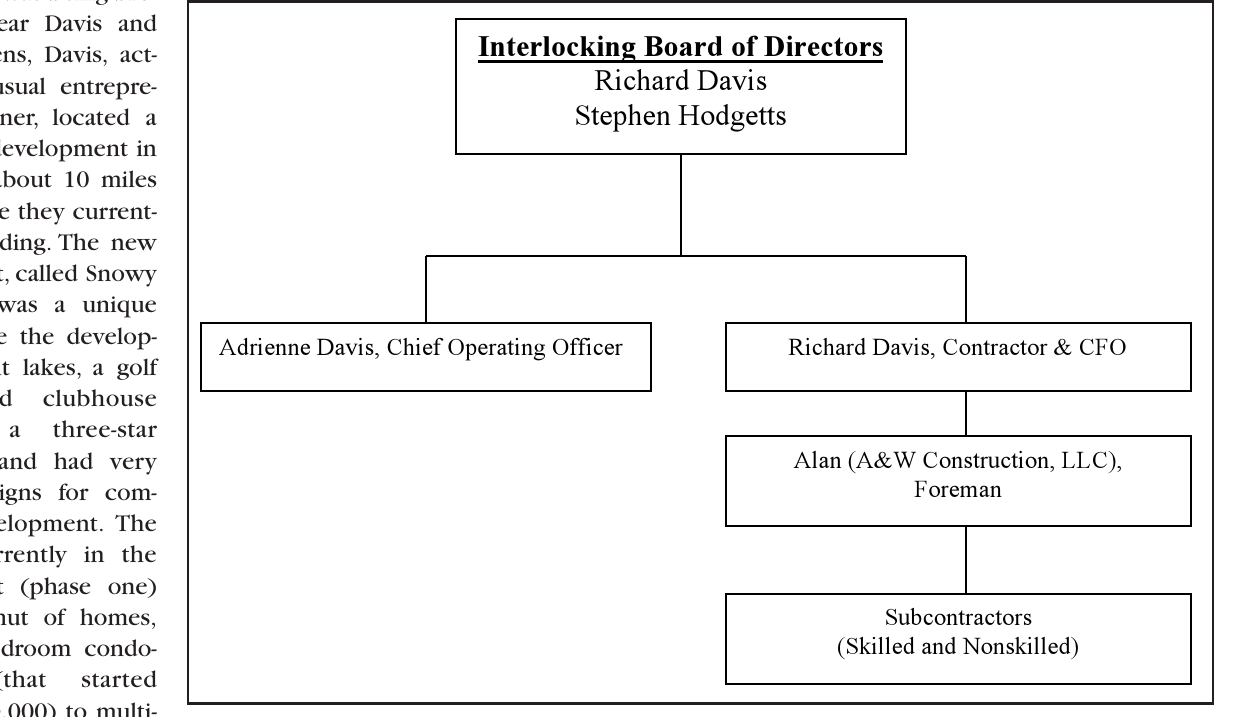
Figure 1. D&H Management, DHR Construction, DHR Patio Homes (June